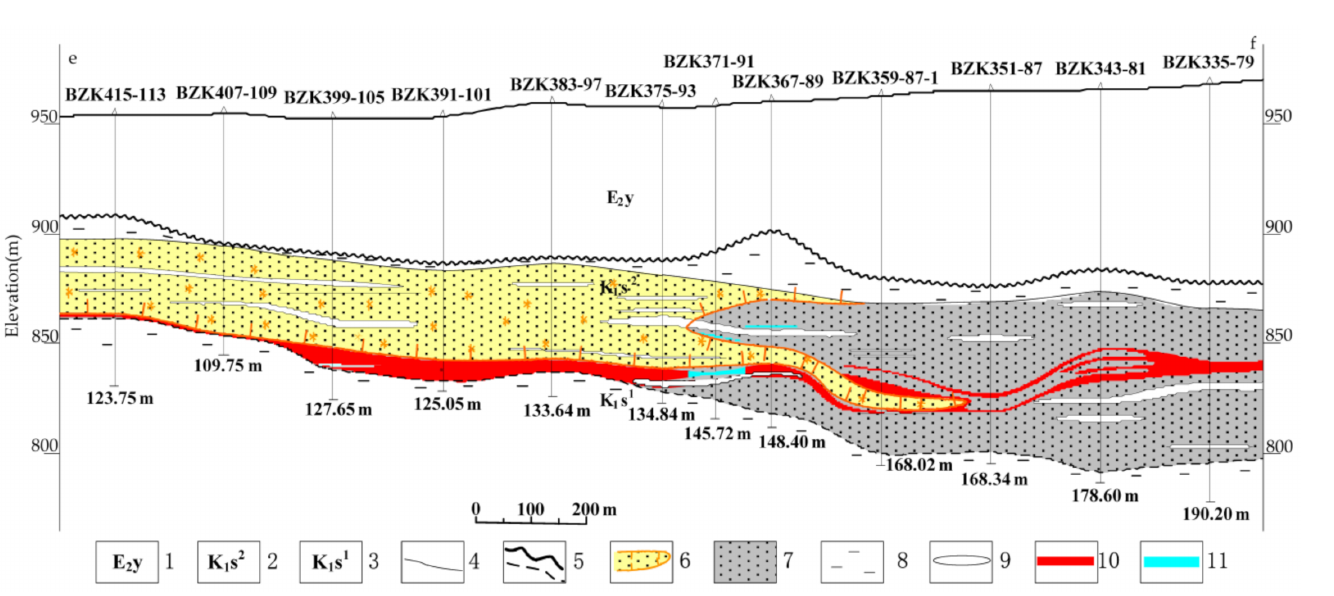
Figure 6. Geological profile of e–f in the Bayanwula uranium deposit. 1—Yierdingmanha group. 2—Upper part of Saihan group. 3—Bottom part of Saihan group. 4—Lithologic boundary. 5— Angle or parallel unconformity boundary. 6—Yellow oxidized sands. 7—Gray reducing sands. 8—Impermeable mudstone. 9—Local impermeable layers. 10—Uranium ore bodies. 11—Uranium